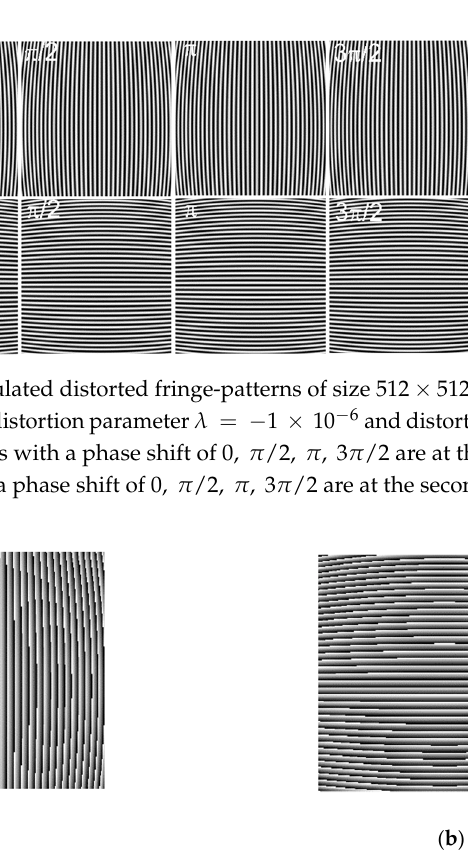
Figure 4. Wrapped phase. ( a ) Wrapped phase of distorted longitudinal fringe-pattern; ( b ) Wrapped phase of a distorted transverse fringe-pattern transverse.